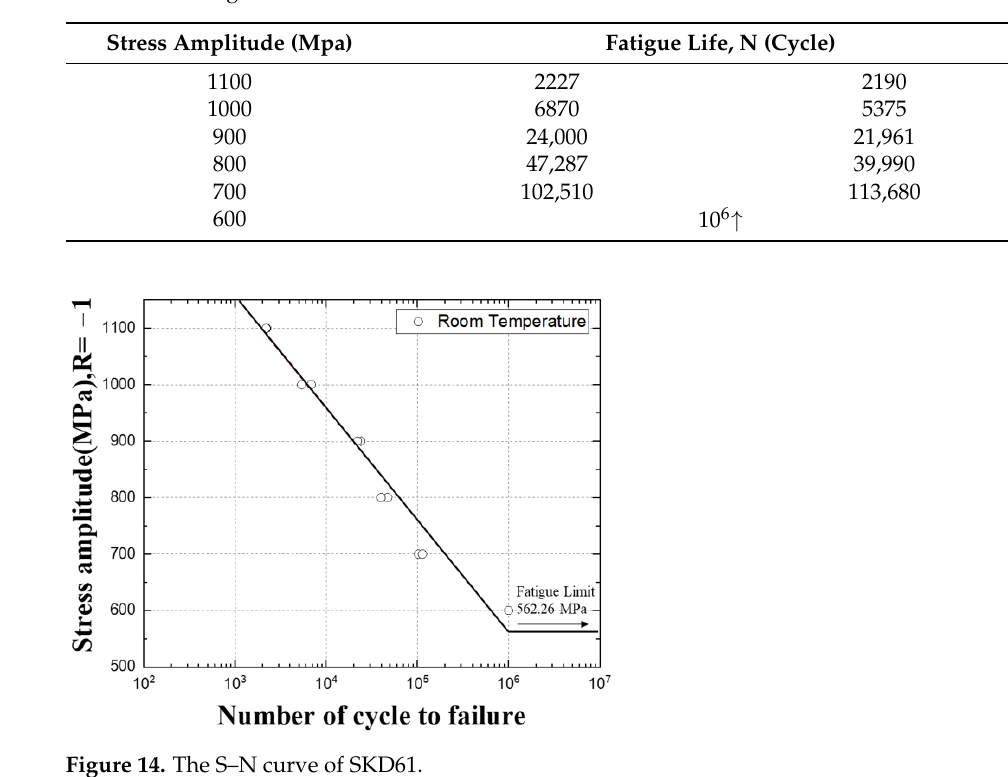
Figure 13. Fatigue test machine.